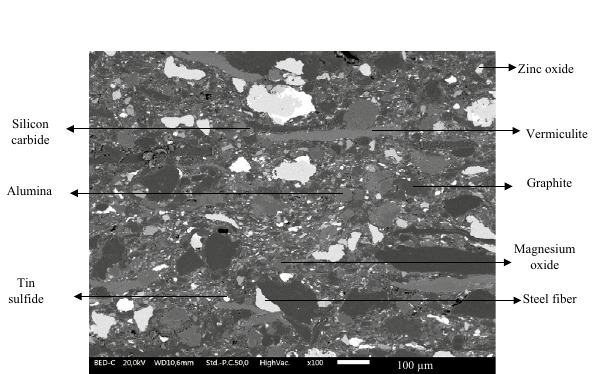
Figure 1. BSE SEM image showing the CFM specimen cross section with few marked constituents.